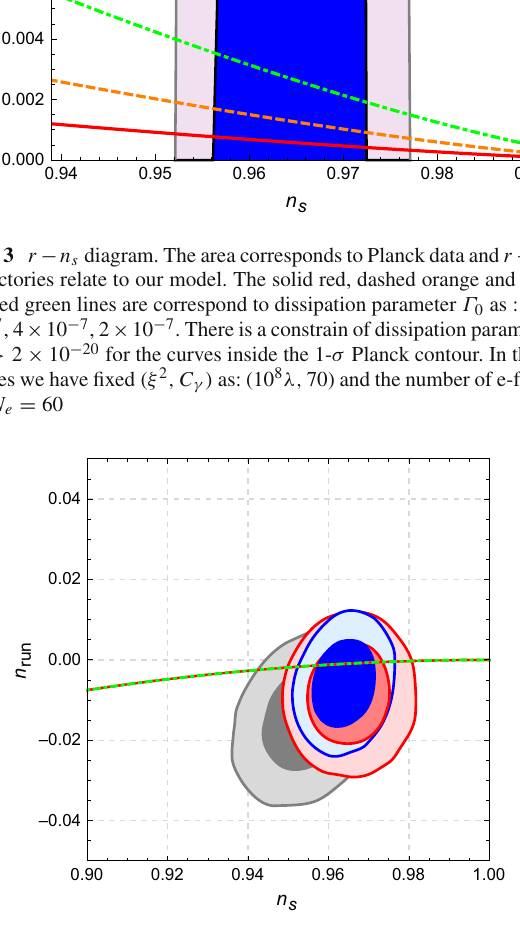
Fig. 4 n s − n run diagram. The area corresponds to Planck data and n s − n run trajectories relate to our model. The solid red, dashed orange and dot-dashed green lines are correspond to dissipation parameter Γ 0 as:8 × 10 − 7 ,4 × 10 − 7 ,2 × 10 − 7 .Inthesecurveswehavefixed (ξ 2 , C γ ) as: (10 8 λ, 70) and the number of e-folds as: N e =